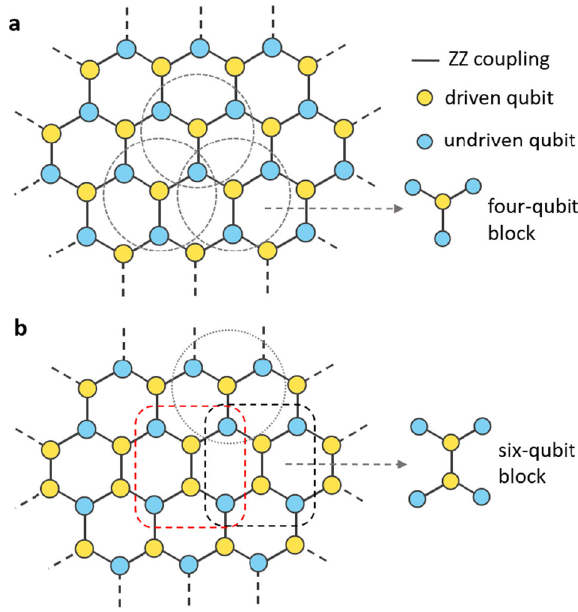
Fig. 2 Hamiltonian decomposition. a An arbitrarily large 2D array of coupled qubits in a honeycomb array. Each link represents a ZZ coupling term. A yellow (cyan) vertex represents a driven (undriven) qubit. The total Hamiltonian can be decomposed into a sum of identical four-qubit blocks that commute with each other (enclosed in the dashed circles). An undriven qubit is shared by three neighbouring blocks. b The pattern of driving for implementing a two-qubit gate, resulting in a central row of identical six-qubit blocks (enclosed by the dashed rectangles). The rest of the array can be decomposed into the four-qubit blocks as in a